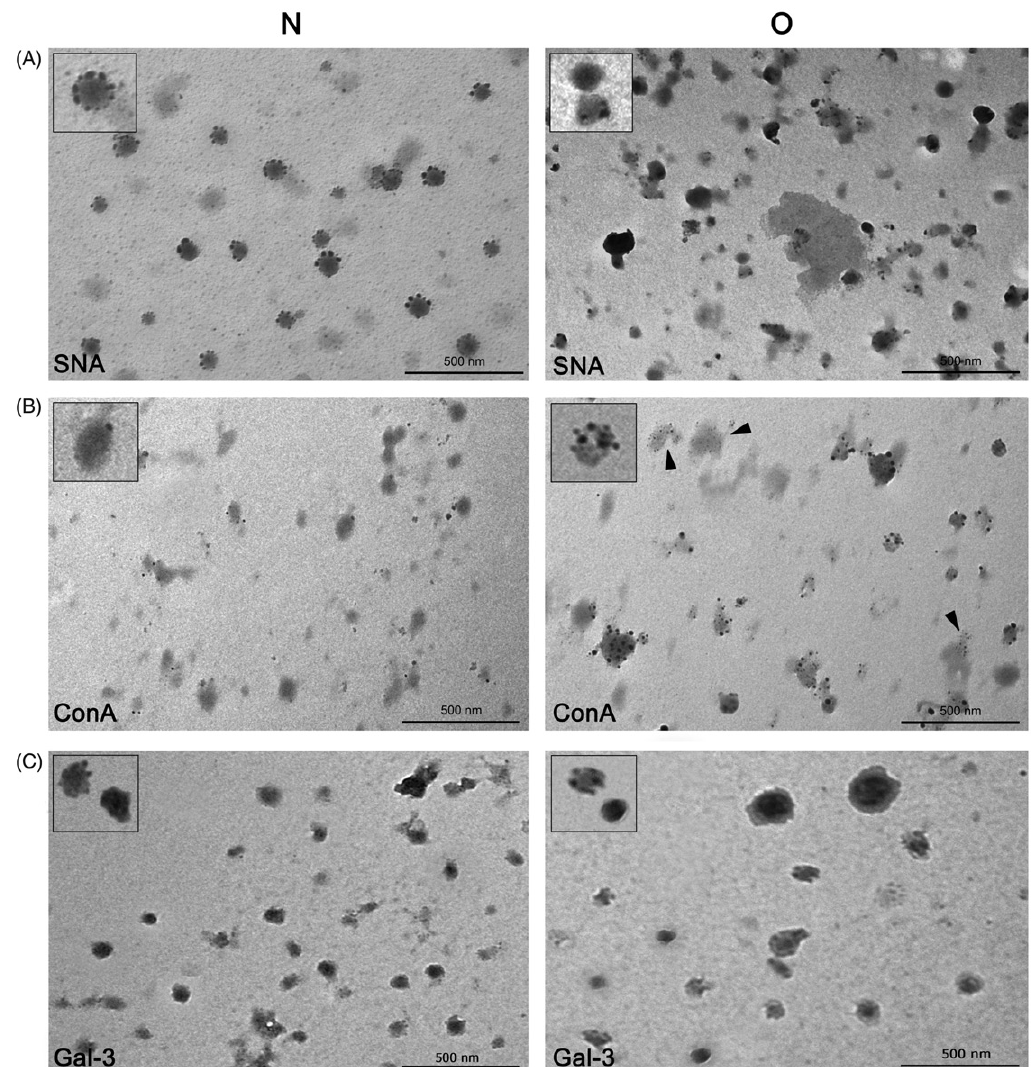
Figure 4. Surface glycosylation of seminal prostasomes: lectin- and immune-transmission electron microscopy. A: Lectin-TEM using SNA. Inserts show enlarged characteristic pattern of SNA-reactivity to each sample group. B: Lectin-TEM using ConA. Inserts show enlarged characteristic pattern of ConA-reactivity to vesicles in each sample group. In O, staining of some proteinaceous material was also observed (arrowheads). C: Immune-TEM using anti-galectin-3 antibodies. Inserts show enlarged characteristic pattern of anti-gal-3-reactivity to each sample group. Micrographs show most characteristic patterns obtained. Although differences in the reactivity of particular vesicles could be noticed, it does not affect the general reactivity of the sample (as in IEC when taking all vesicles into account). (N ¼ seminal prostasomes from normozoospermic men; O ¼ seminal prostasomes from oligozoospermic